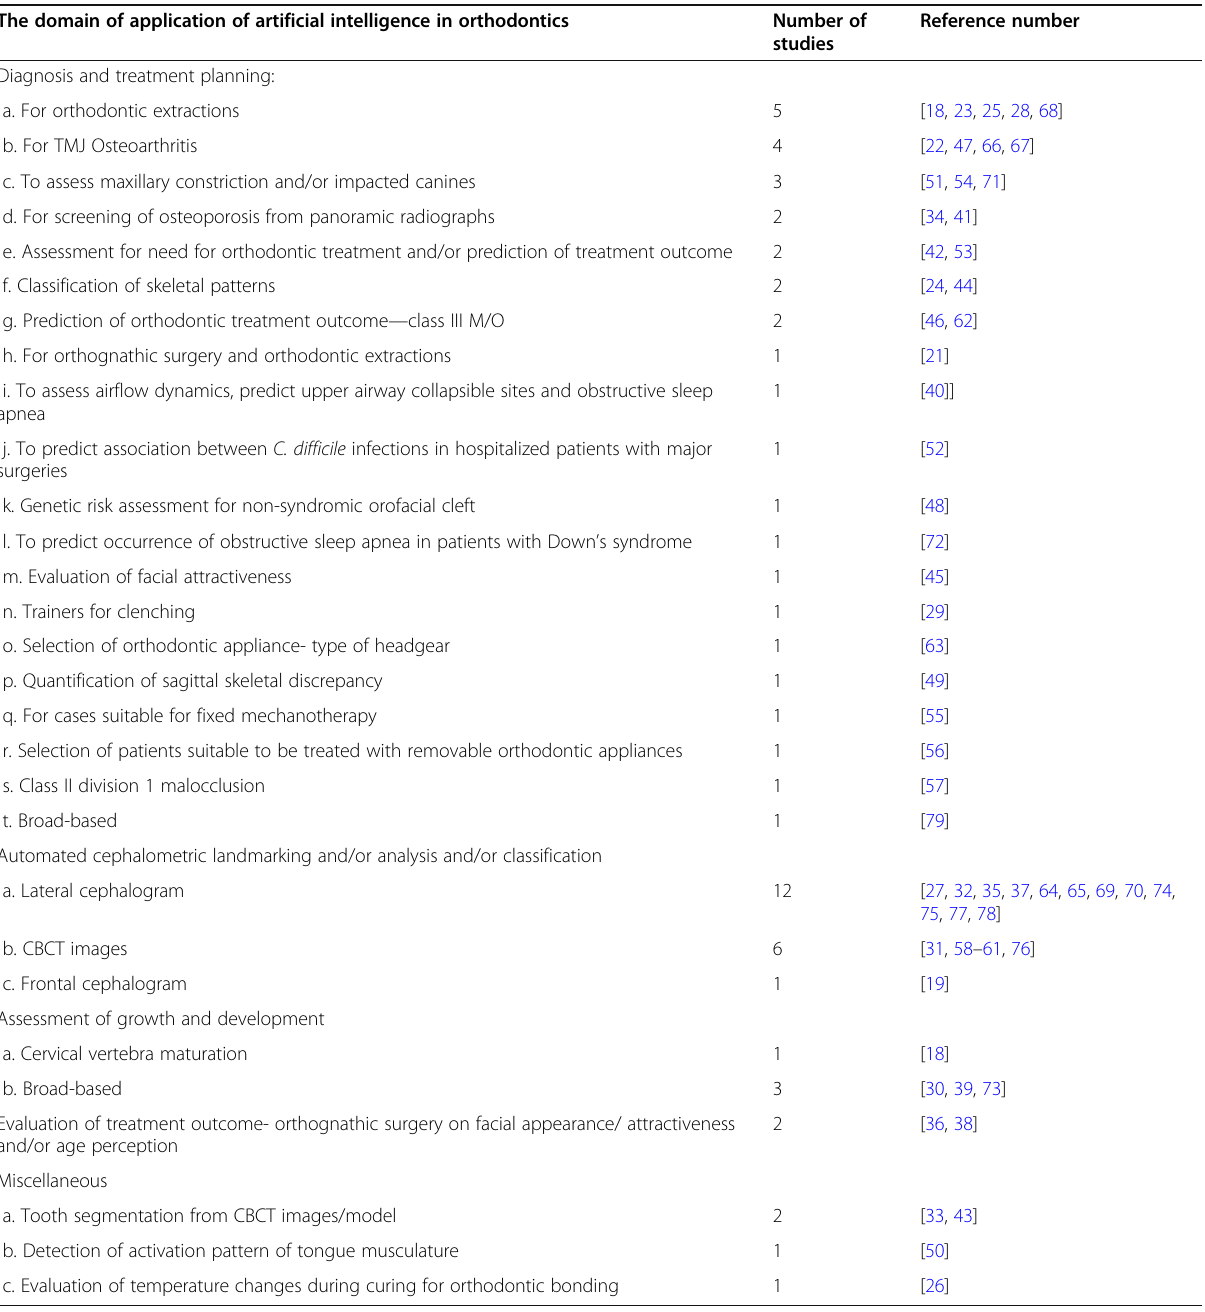
Table 4 Studies classified as per domains of applications of artificial intelligence in orthodontics The domain of application of artificial intelligence in